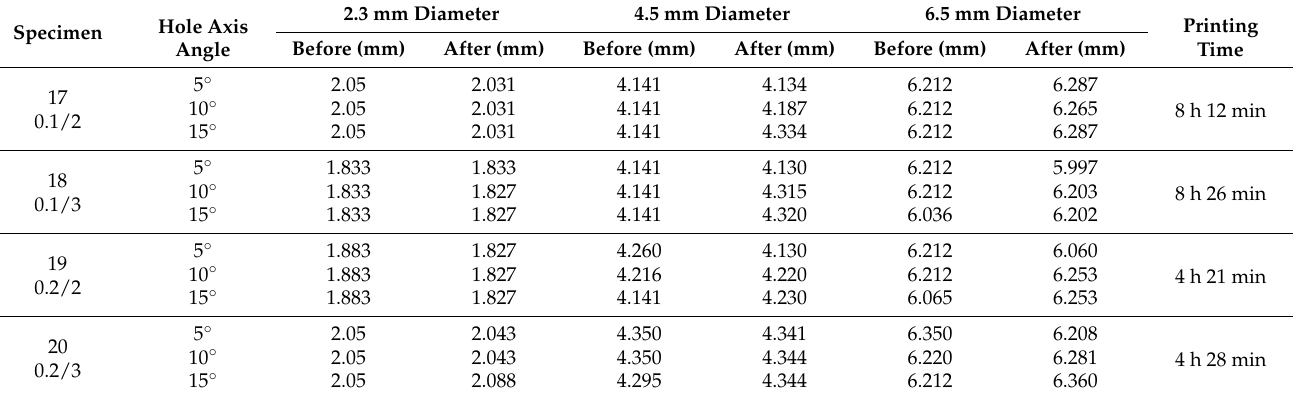
Table 6. Test part measurement data for experiment 2 before and after the medical decontamination.